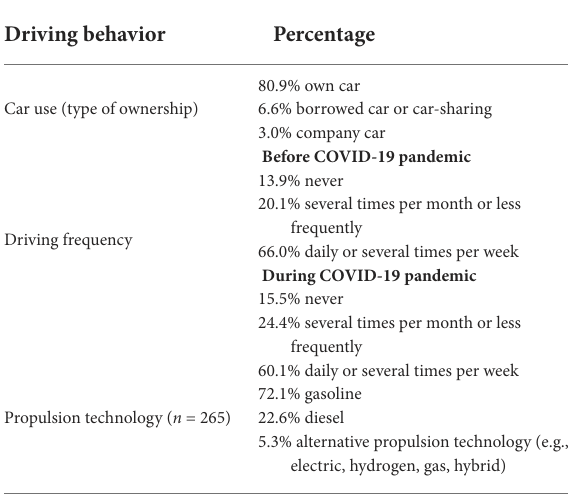
TABLE 3 Driving behavior ( n =